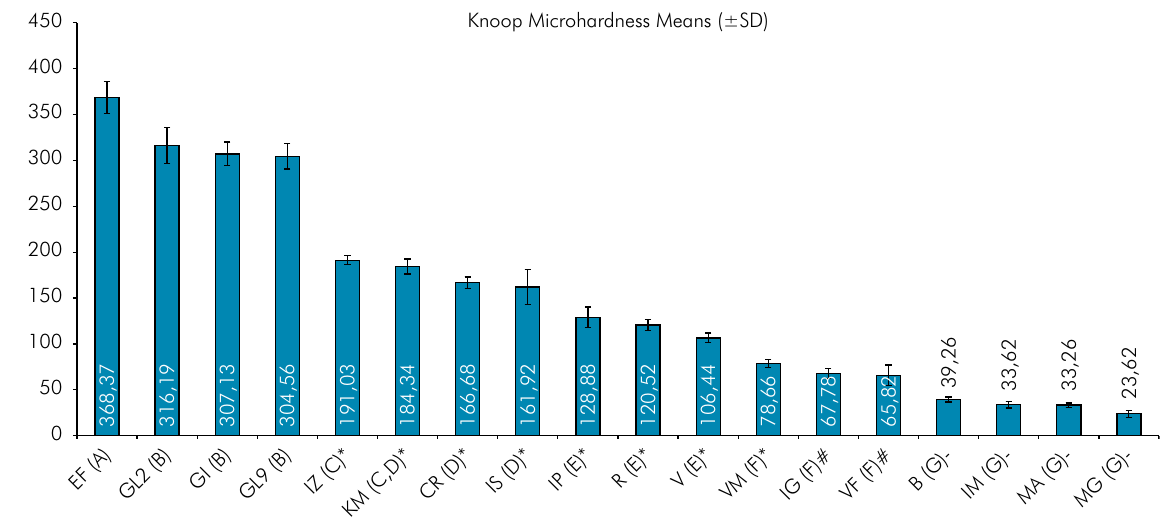
Figure 2. Means and standard deviations for KH of 18 different GICs. Bars with the same letters under them present no statistical difference (p > 0.05). Groups with no marks presented KH similar to enamel’ hardness; groups marked with (*) presented KH intermediate between enamel and dentin values; groups marked with (#) presented KH similar to dentin hardness, and groups marked with (-) did not approach the minimum dentin hardness.